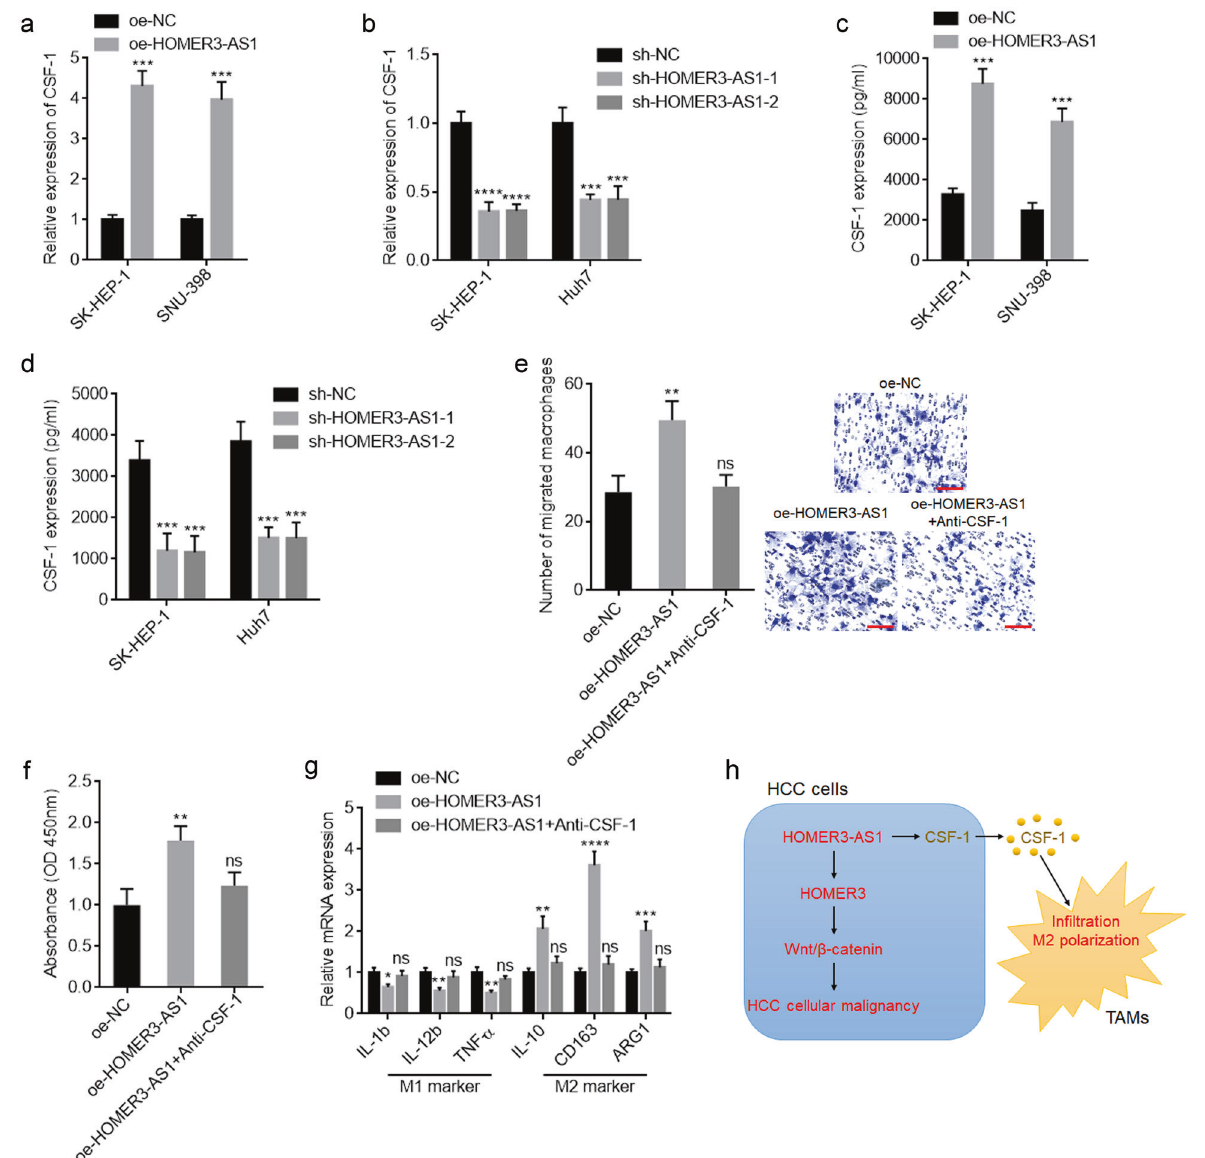
Fig. 7 HOMER3-AS1 promoted macrophages in fi ltration and M2-like polarization via upregulating CSF-1. a CSF-1 expression in SK-HEP-1 and SNU-398 cells with HOMER3-AS1 stable overexpression was measured by qRT-PCR. b CSF-1 expression in SK-HEP-1 and Huh7 cells with HOMER3-AS1 stable silencing was measured by qRT-PCR. c CSF-1 secretion from SK-HEP-1 and SNU-398 cells with HOMER3-AS1 stable overexpression was measured by ELISA. d CSF-1 secretion from SK-HEP-1 and Huh7 cells with HOMER3-AS1 stable silencing was measured by ELISA. e PMA-stimulated THP-1 cells were subjected to migration assays towards CM from HOMER3-AS1 overexpressed SK-HEP-1 cells treated with or without anti-CSF-1. f Cell proliferation of PMA-stimulated THP-1 cells after culture with CM from HOMER3-AS1 overexpressed SK-HEP-1 cells treated with or without anti-CSF-1. g Expression of markers associated with M1 and M2 polarization in PMA-stimulated THP-1 cells after culture with CM from HOMER3-AS1 overexpressed SK-HEP-1 cells treated with or without anti-CSF-1. h Schematic model of the roles of HOMER3-AS1 in regulating HCC cellular malignancy and TAMs in fi ltration and polarization. Results are presented as mean ± SD based on three independent experiments. * p < 0.05, ** p < 0.01, *** p < 0.001, **** p < 0.0001, ns, not signi fi cant, by Student ’ s t -test ( a , c ) or one-way ANOVA followed by Dunnett ’ s multiple comparisons test ( b , d - g